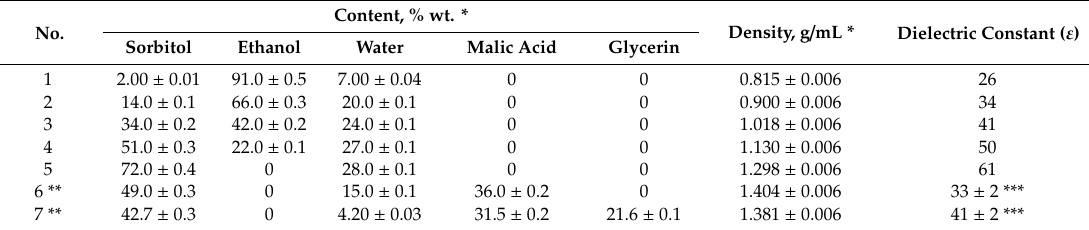
Table 3. The content and dielectric constants of sorbitol-based